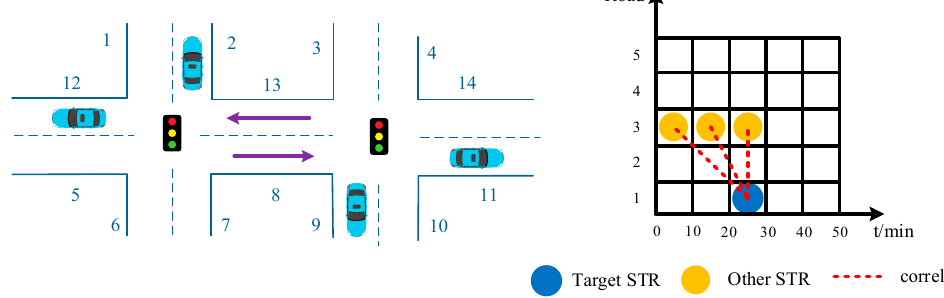
Figure 1. Schematic of a traffic road network.